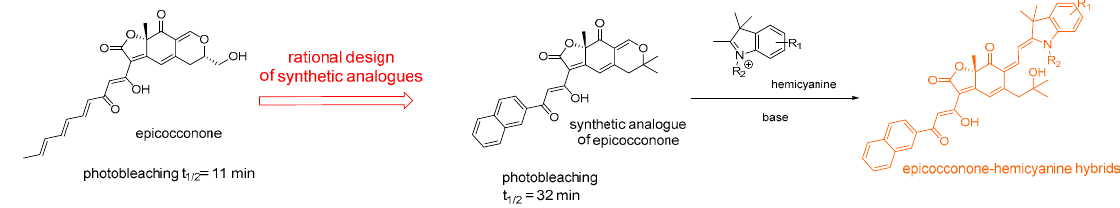
Figure 14. Epicocconone, synthetic analogues, and hybrids.